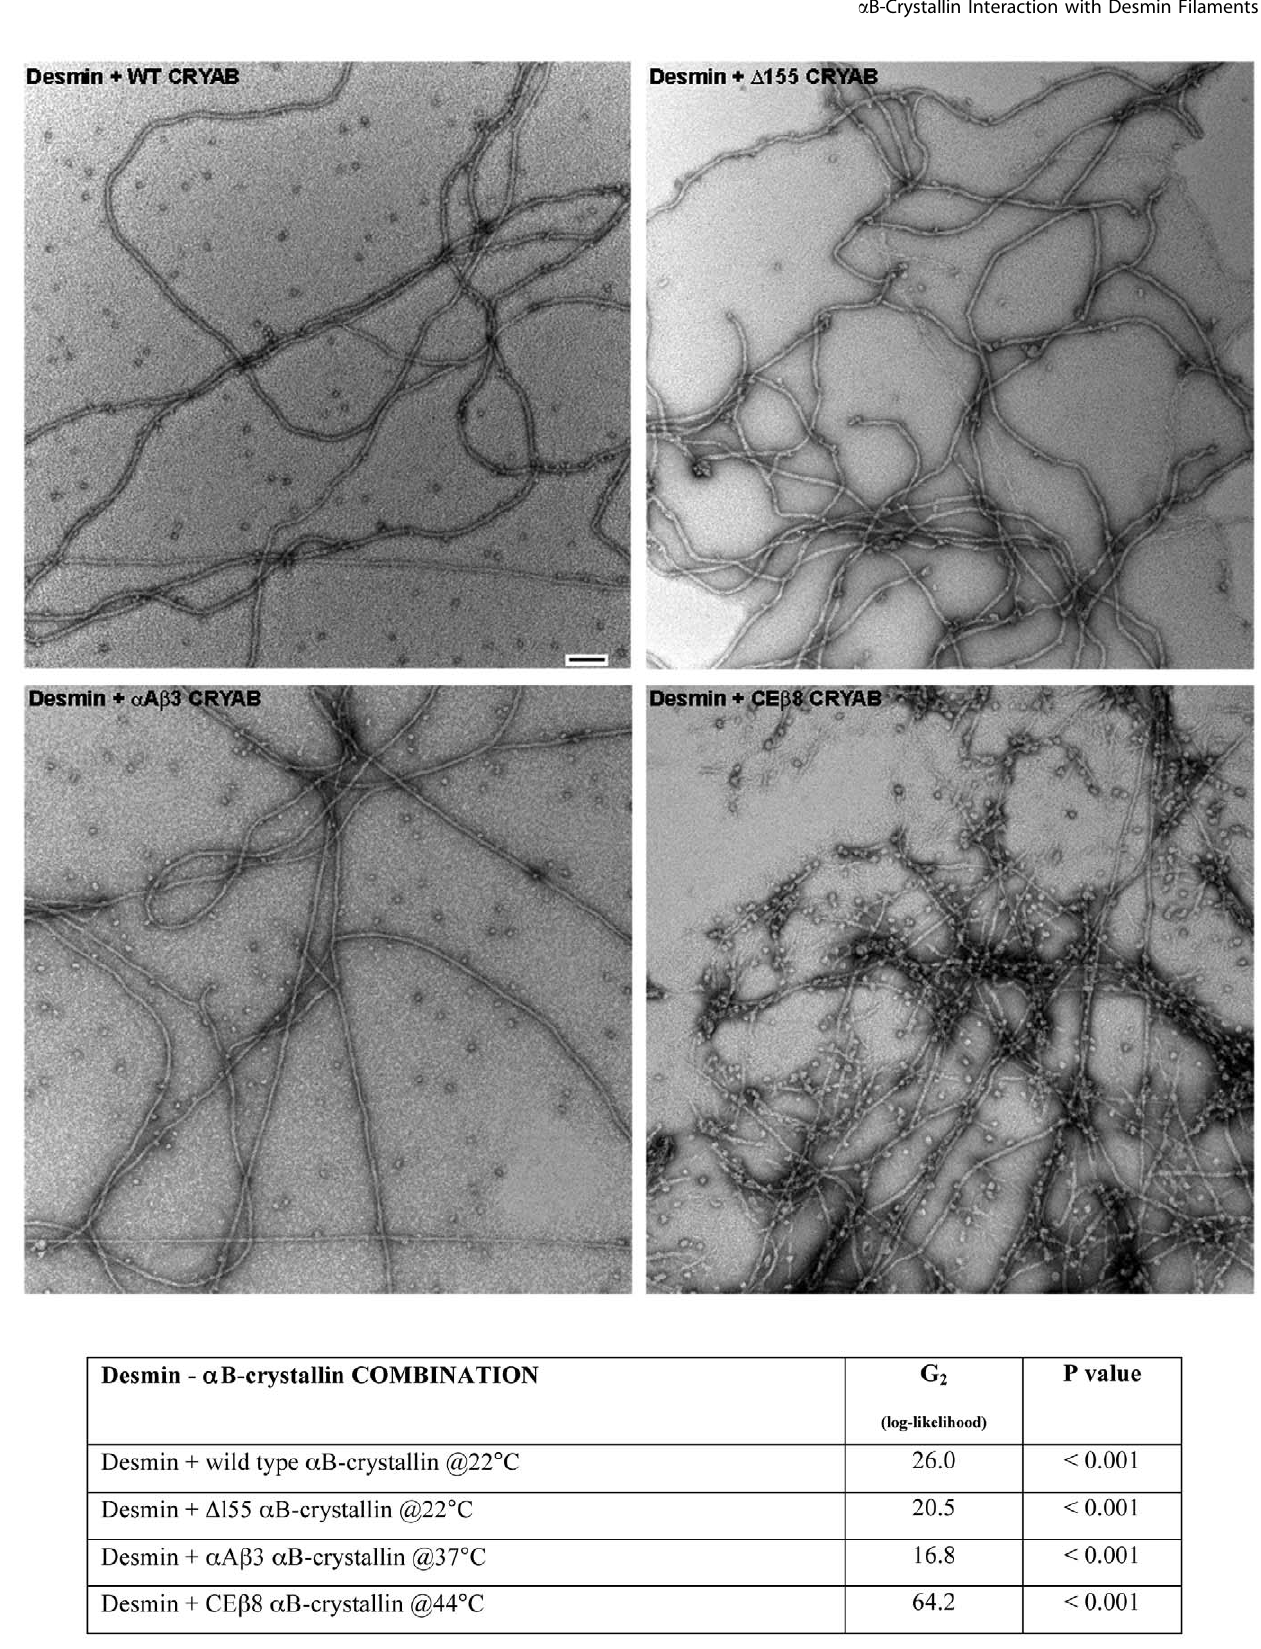
Figure 4. Analysis of a B-crystallin interaction with desmin filaments using a likelihood ratio test (LRT). Samples from the shown combinations of desmin and a B-crystallin were analysed by the described LRT. Examples of some of the selected images are shown. Strong statistical evidence (G2 log-likelihood scores 16.8–64.2, P values= , 0.001%) was found that the a B-crystallin particles of the samples tested were positively associated with the desmin filaments (see summary table) in these samples. Bar=100 nm. doi:10.1371/journal.pone.0025859.g004 PLoS ONE |